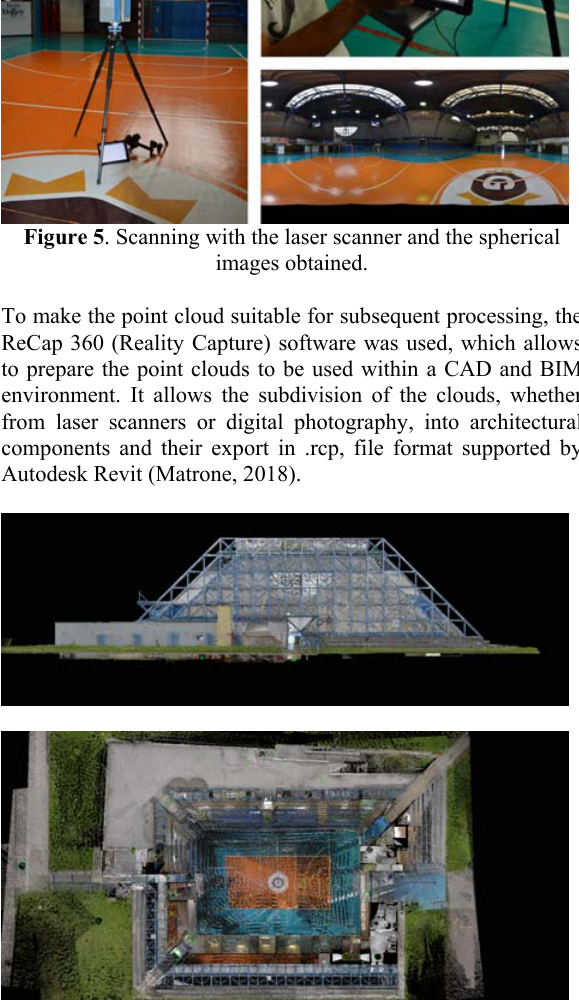
Figure 6 . The point cloud obtained by the laser